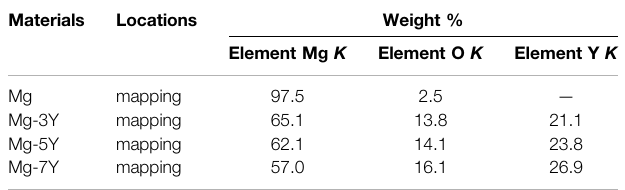
TABLE 4 | The EDS results of oxides of different materials. Materials